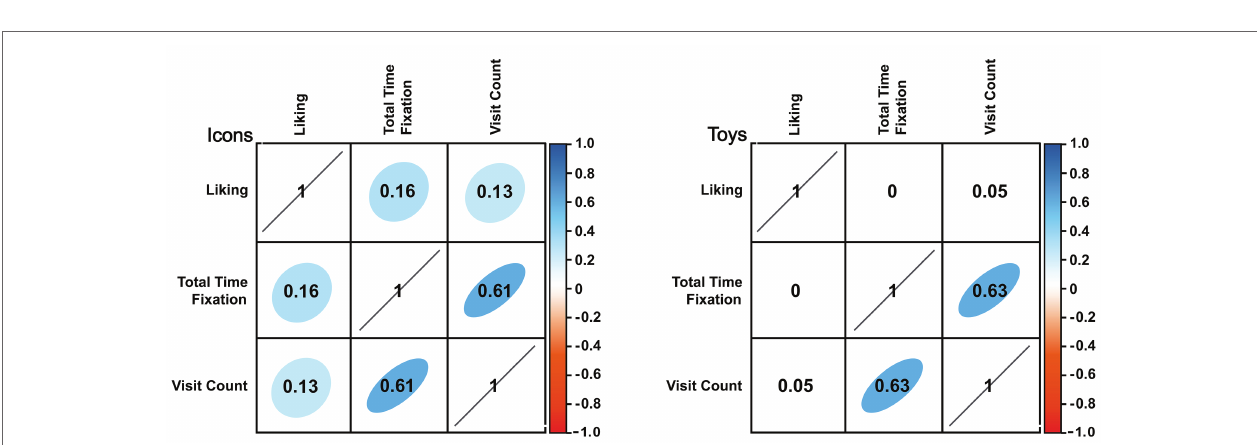
FIGURE 6 | Correlations between liking and visual attention. Number in the table shows the Pearson correlation coefficient, and the background is highlighted from red to blue in case of p < 0.05. Figure result for icons in left side and figure results for toys in right